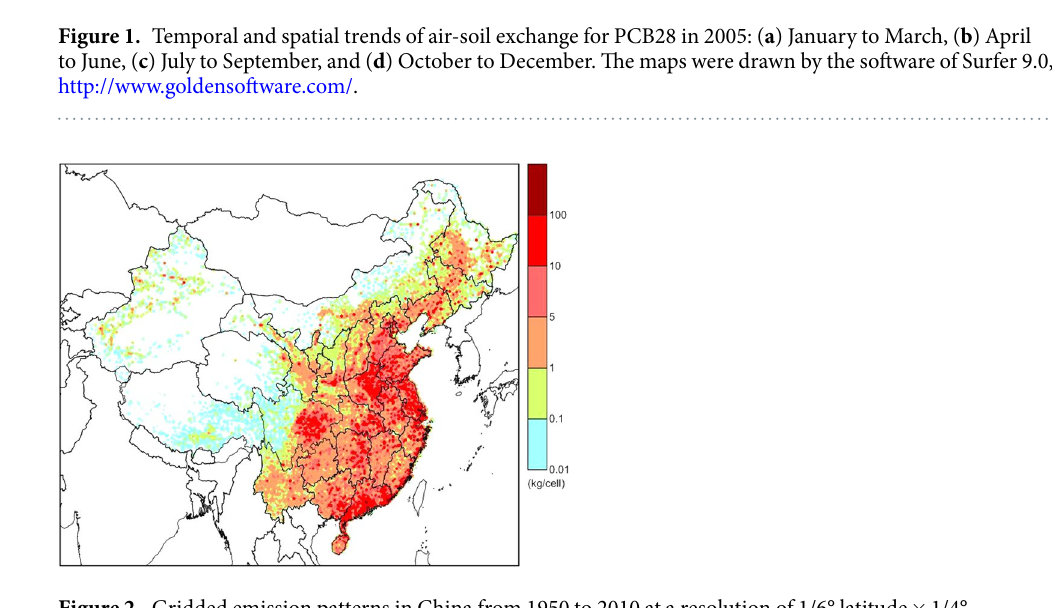
Figure 2. Gridded emission patterns in China from 1950 to 2010 at a resolution of 1/6° latitude × 1/4° longitude32. The maps were drawn by the software of Surfer 9.0,